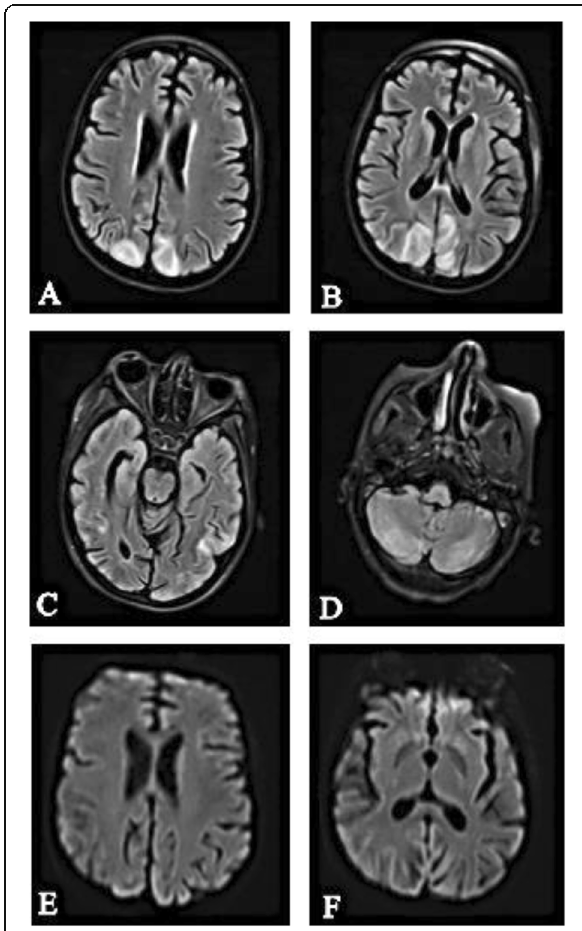
Fig. 5 Typical pattern of posterior reversible encephalopathy syndrome. Female patient, 13 years old, treated for ALL at the maintenance phase presented with headache and seizure axial MRI of the brain. a – d FLAIR images show bilateral cortical and subcortical areas of bright signal involving both the parietooccipital regions and both the cerebellar hemisphere ( e , f ). DWI of the patient show no evidence of diffusion